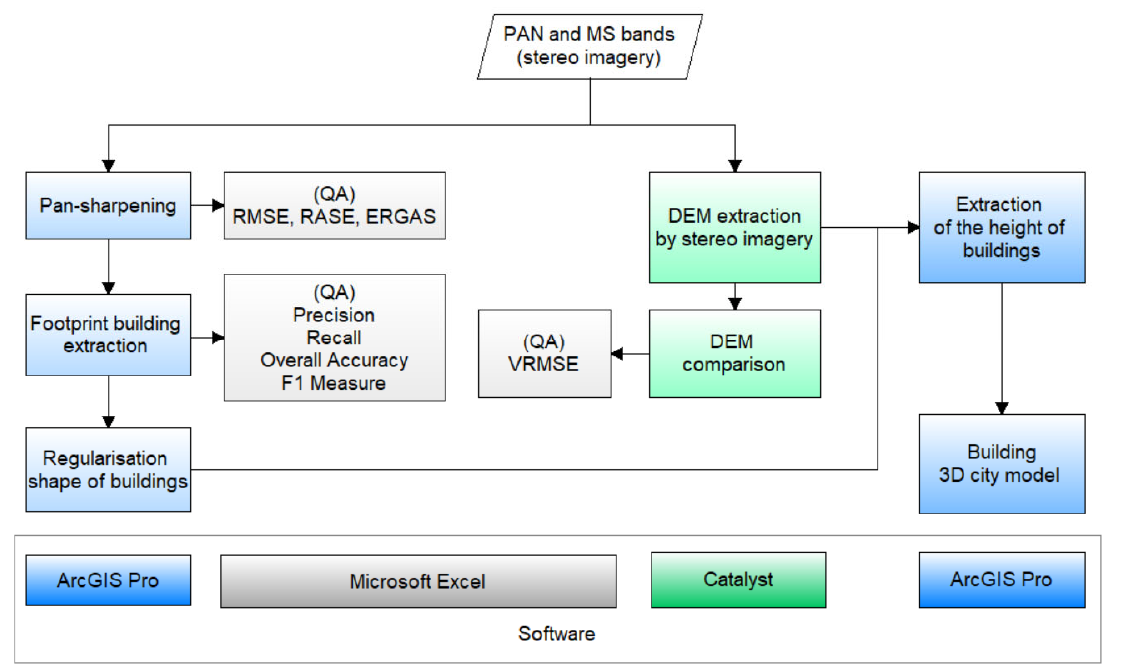
Figure 2. Workflow of operations and software used in order to obtain the 3D city model.